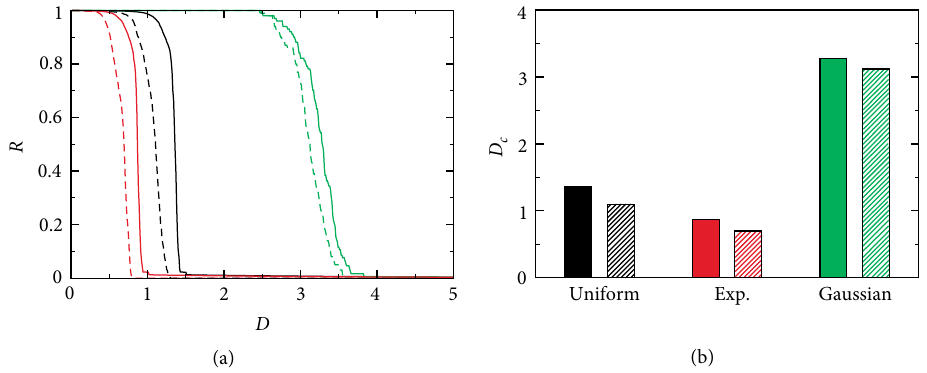
Figure 4: (a) Market robustness 𝑅 as the function of transmitting shock level 𝐷 in external and internal link coupling scenario with ER random network (solid lines) and Scale-Free network (dashed lines) for internal links, with different weight distributions: uniform 𝐶 ∼ 𝑈 [0, 10] (black), exponential 𝐶 ∼ Exp [5] (red) and truncated normal 𝐶 ∼ 𝑁 (𝐶 = 5, 𝜎 = 1) in the range [0, 10] (green). Both layers have ⟨𝑘 in ⟩ = 4 and 𝑇 = 0.5 . For the SF network, the minimum connectivity is 𝑘 min = 2 , the maximum connectivity 𝑘 max is the size of each layer, and 𝜆 = 2.65 . The results were averaged over 100 realizations. (b) Values of 𝐷 obtained from panel (a), for each weight distribution for ER internal networks 𝑐 (solid area) and SF internal networks (dashed